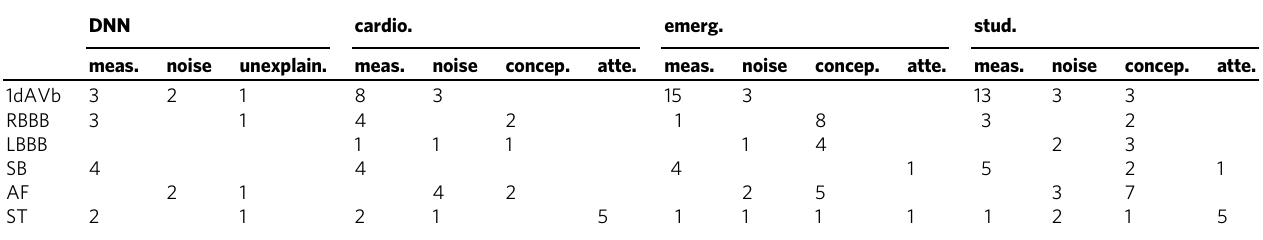
Table 3 (Error analysis) Present the analysis of misclassi fi ed exams. DNN cardio. emerg. stud. meas. noise unexplain.